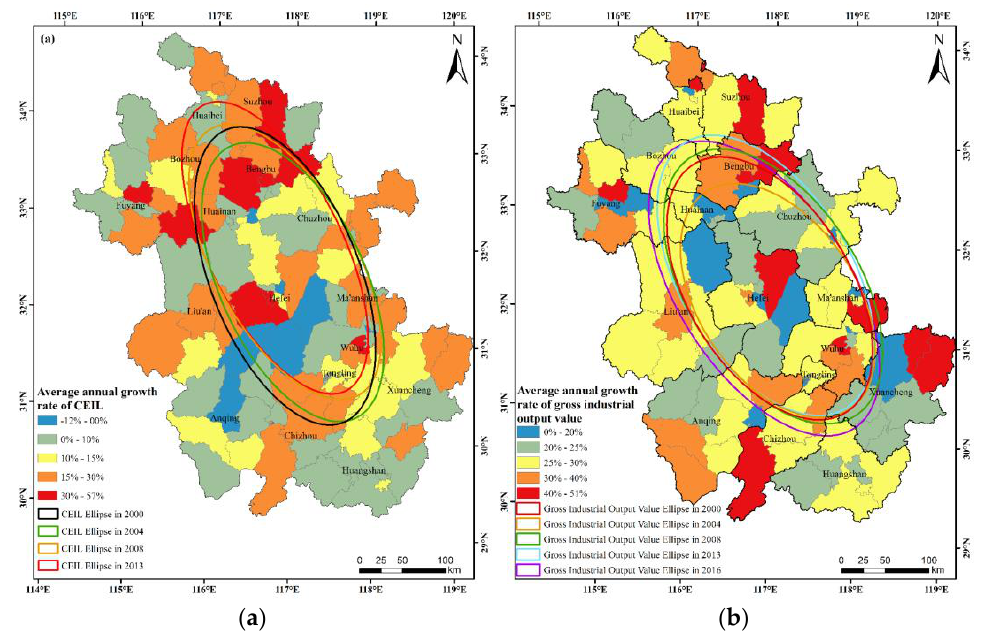
Figure 9. Comparison of the standard deviation ellipse shape indices of GIOV and CEIL in Anhui Province from 2000 to 2016.